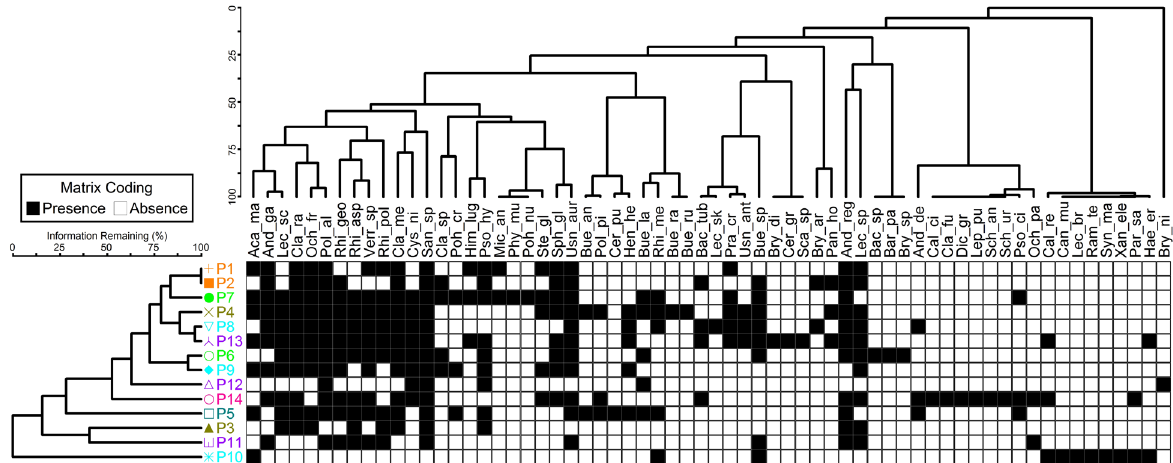
Figure 6. Distribution of 64 species within 174 samples plots installed along a pedoenvironmental gradient by a two way cluster dendrogram based on Euclidian distance. See full names of the species in Table SIb from